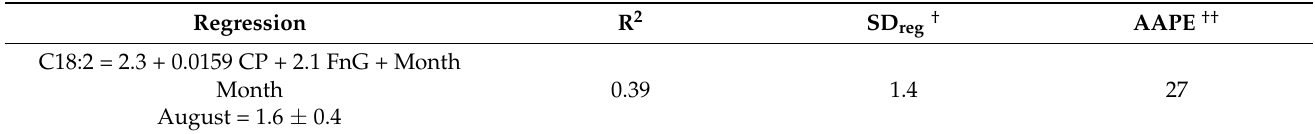
Table 4. Regression analysis of total fatty acid (TFA), linoleic acid (C18:2), and α -linolenic acid (C18:3) content (g kg − 1 ) in forage grasses, legumes, and forbs based on their crude protein (CP)